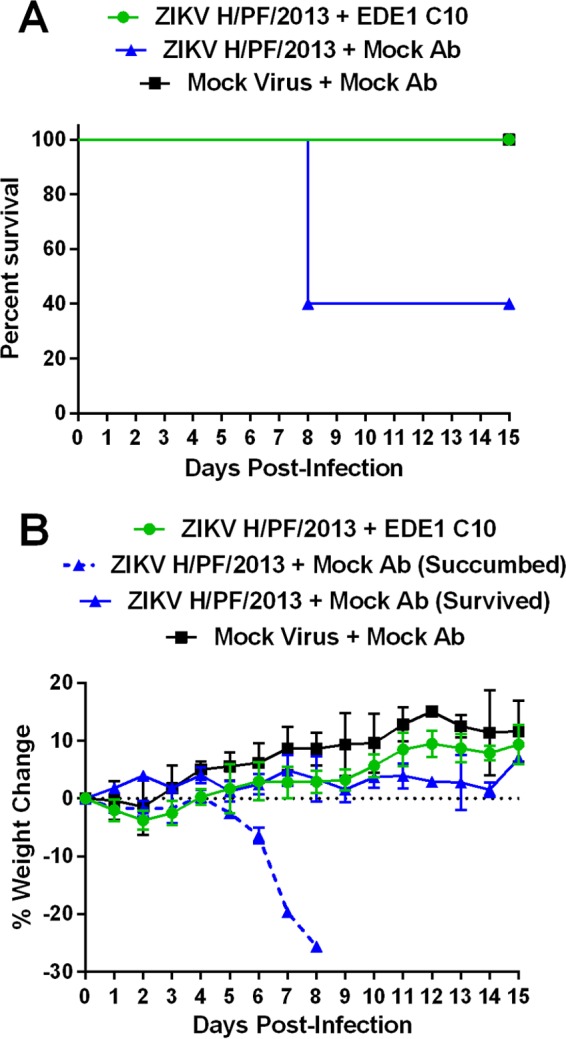
EDE1 C10 protects ZIKV-susceptible mice from infection. Five-week-old type I/II interferon receptor-knockout mice on a C57BL/6 backbone received either EDE1 C10 (n = 5) or mock (n = 5) treatment and were challenged with 102 FFU of ZIKV H/PF/2013. A mock cohort (n = 2) was also included. Survival (A) and weight loss (B) were monitored, and differences between the mock-treated and EDE1 C10-treated cohorts are shown.